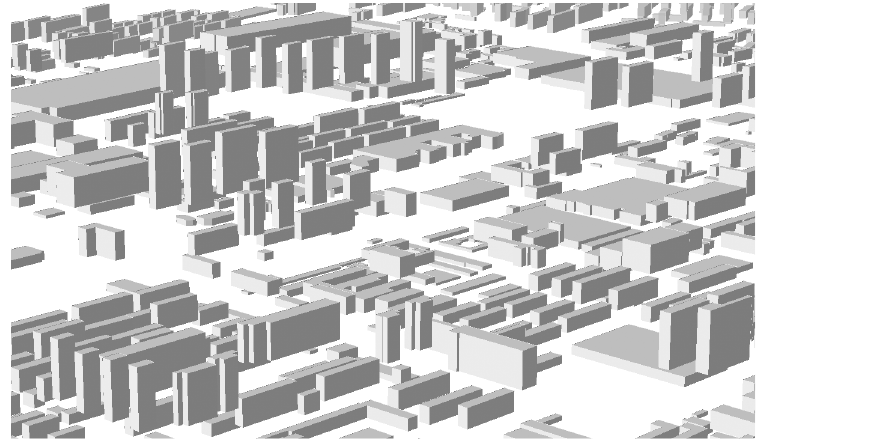
Fig 2. Extracted results of buildings ’ three-dimensional information.